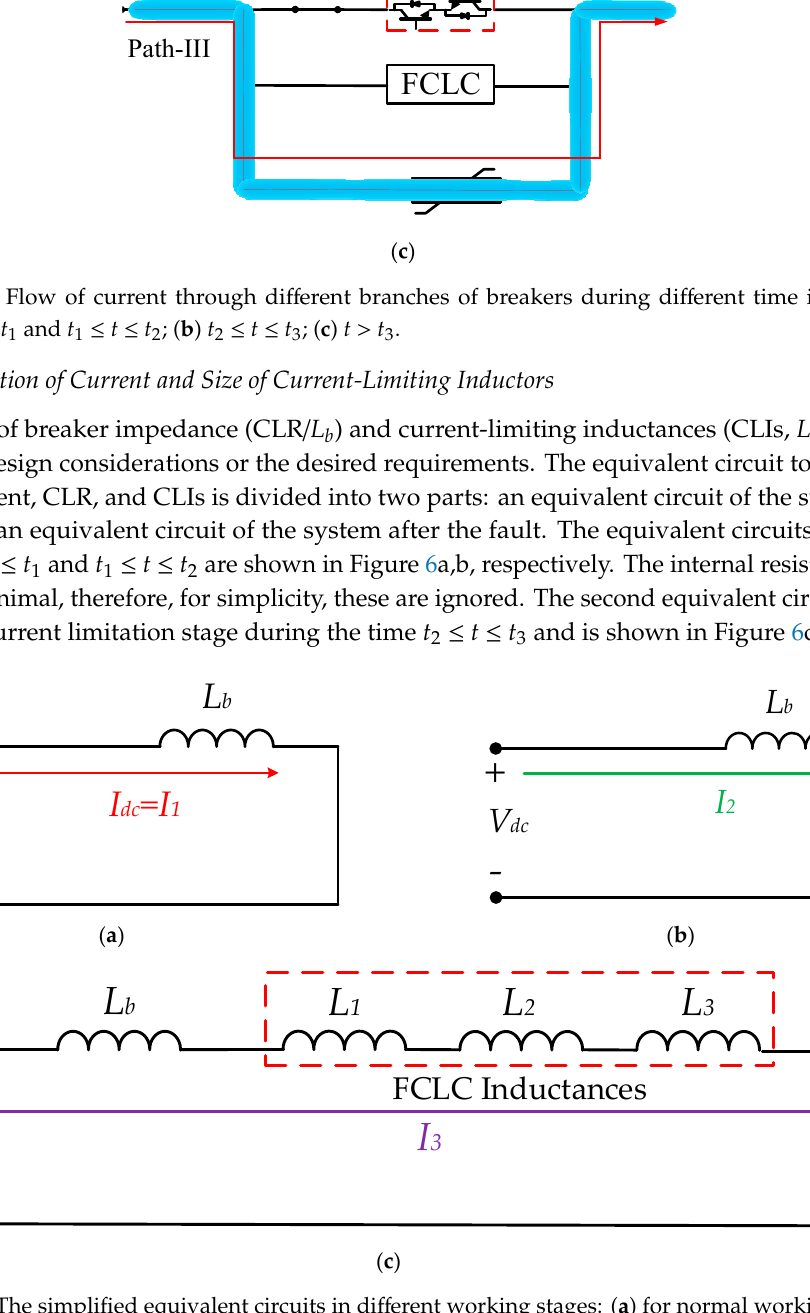
Figure 6. The simplified equivalent circuits in di ff erent working stages: ( a ) for normal working stage; ( b ) for fault suspect / confirmation stage; ( c ) for fault current limitation stage.